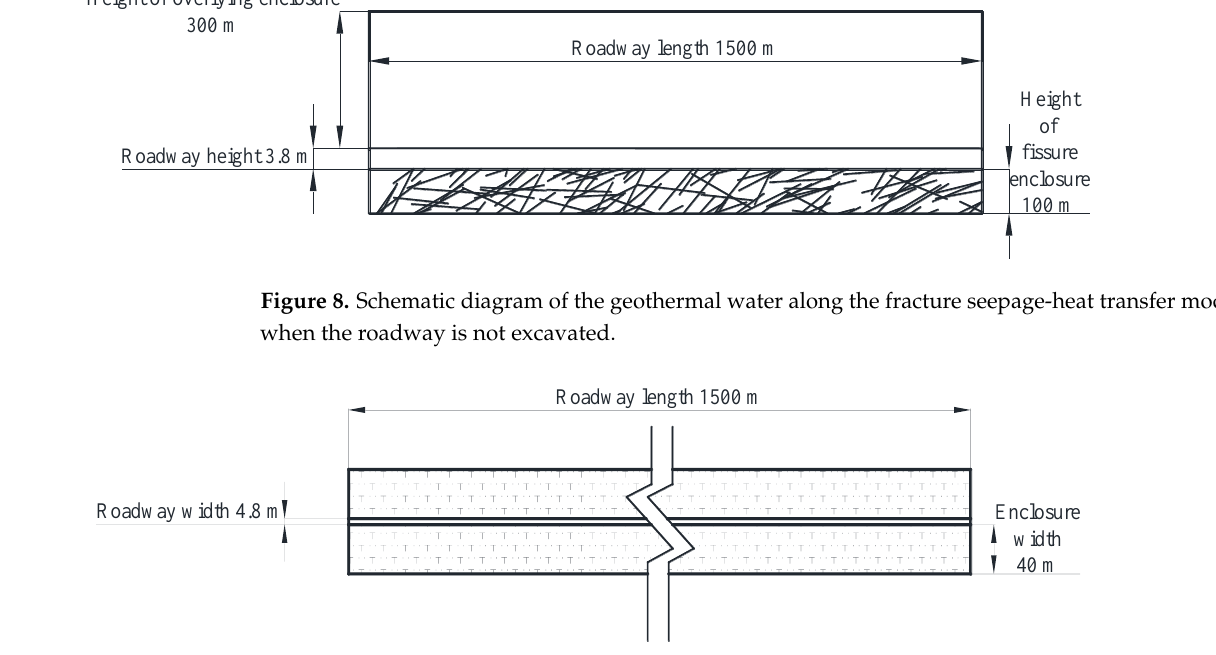
Table 2. Error analysis of each measurement point after gradual encryption of the model grid Grid Division